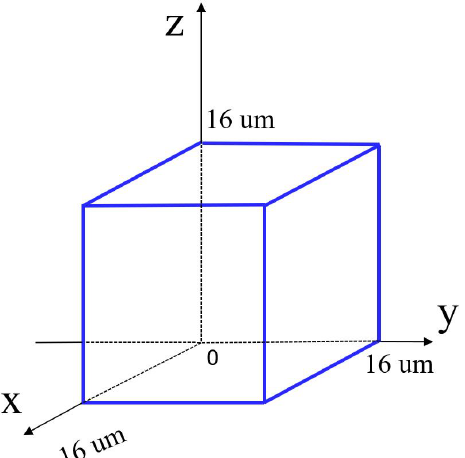
Figure 10. The reachable workspace of the proposed triaxial compliant manipulator.